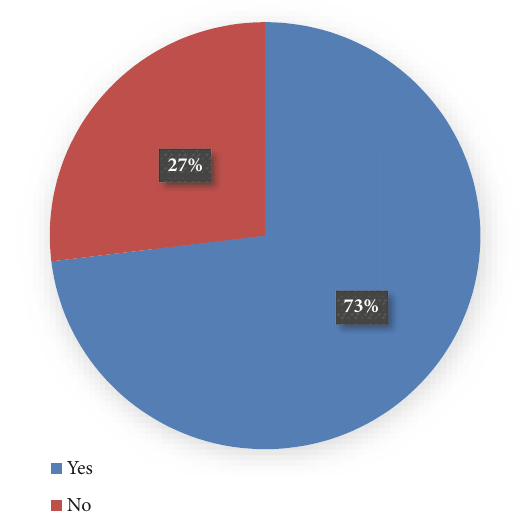
Figure 1: Proportion of respondents knowledgeable with danger signs of infancy. Most of the caregivers knew the danger signs in infancy.